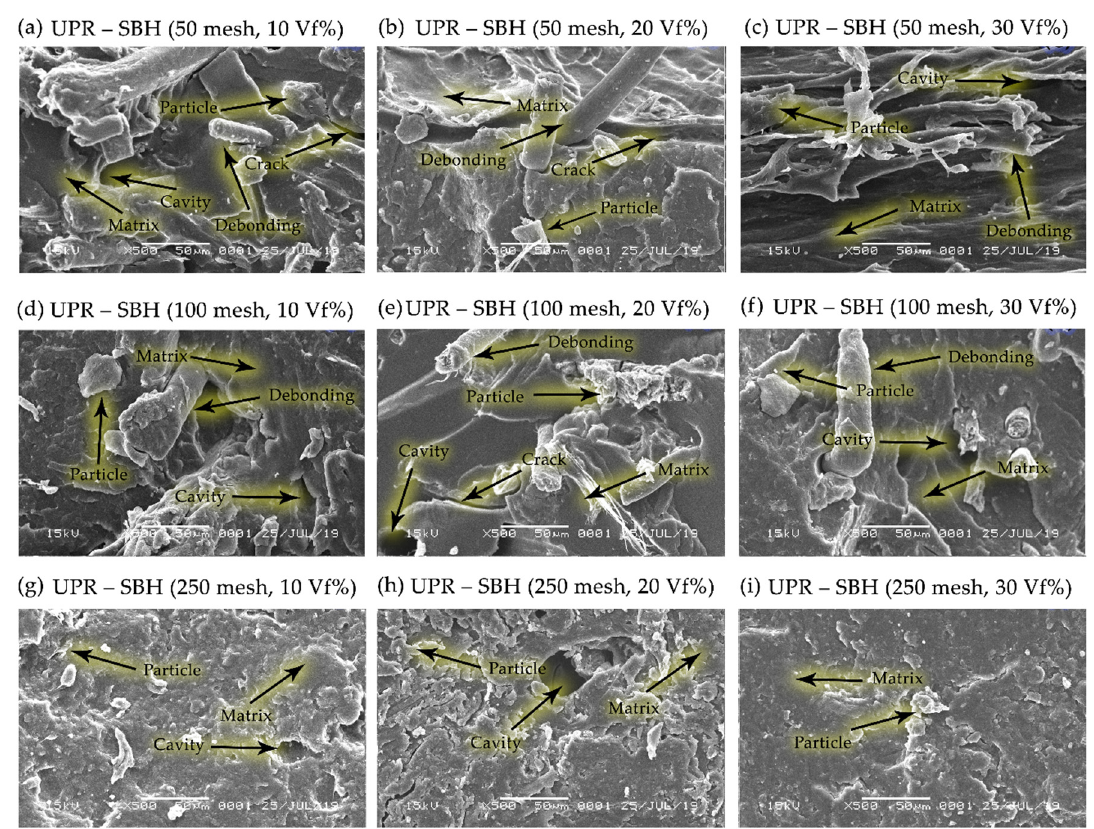
Figure 15. SEM micrographs on the morphology of the UPR–SBH composites.